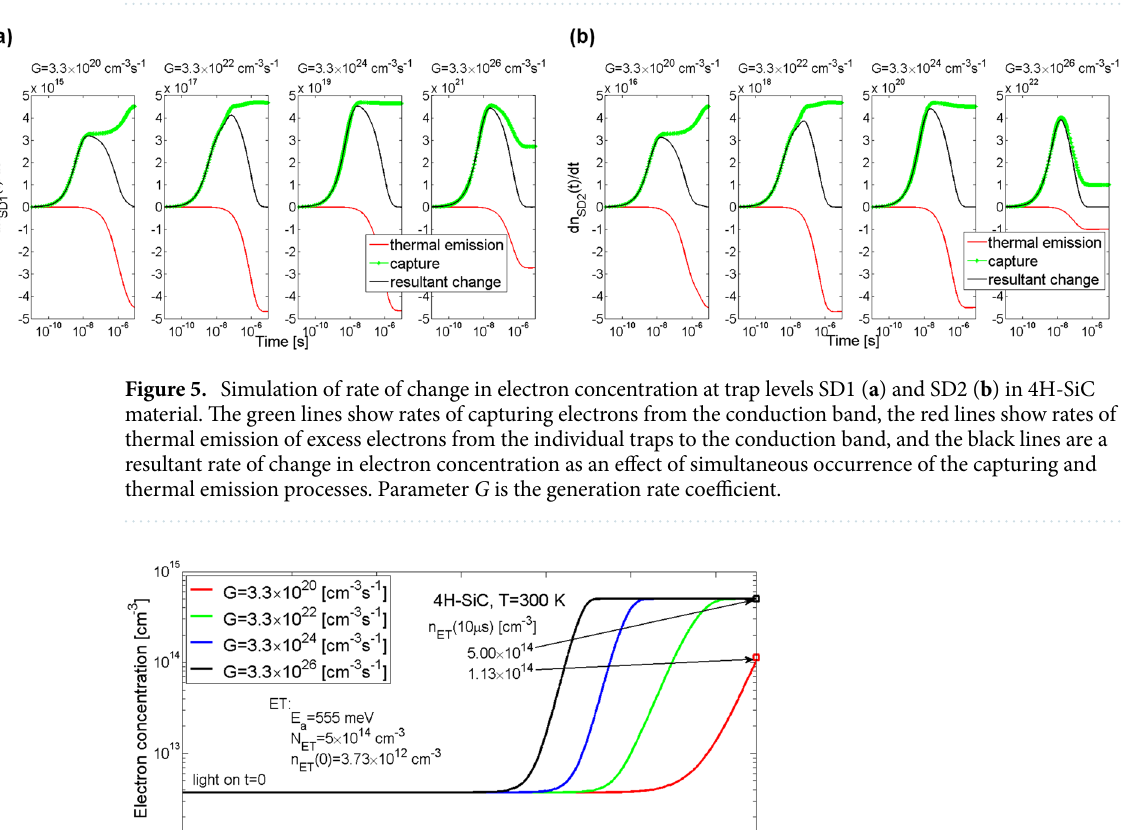
Figure 4. Simulation of temporal changes in electron concentration at trap levels of the shallow donors SD1 ( a ) and SD2 ( b ) in 4H-SiC material. Parameter G is the generation rate coefficient.